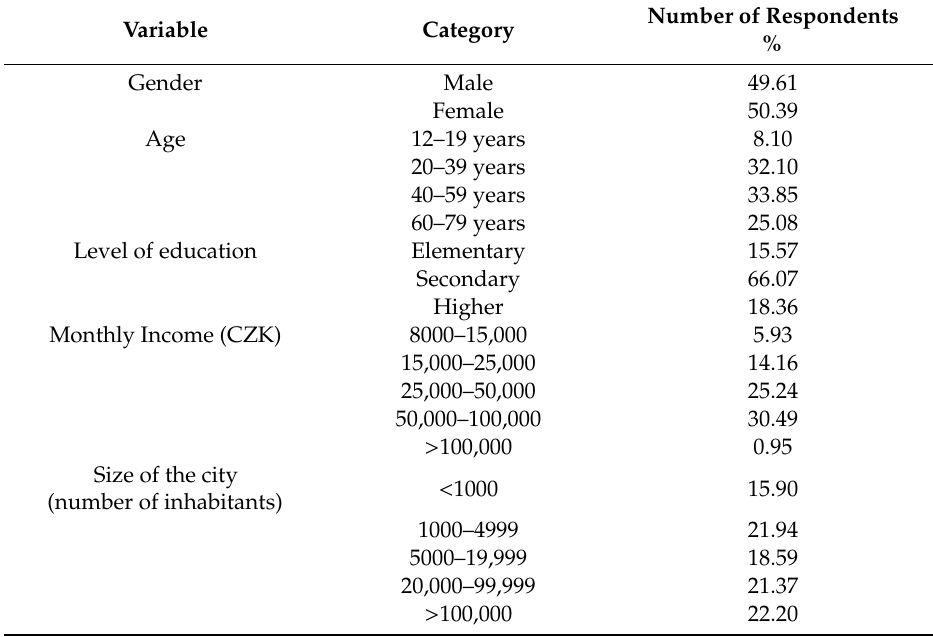
Table 1. The socioeconomic data features of the